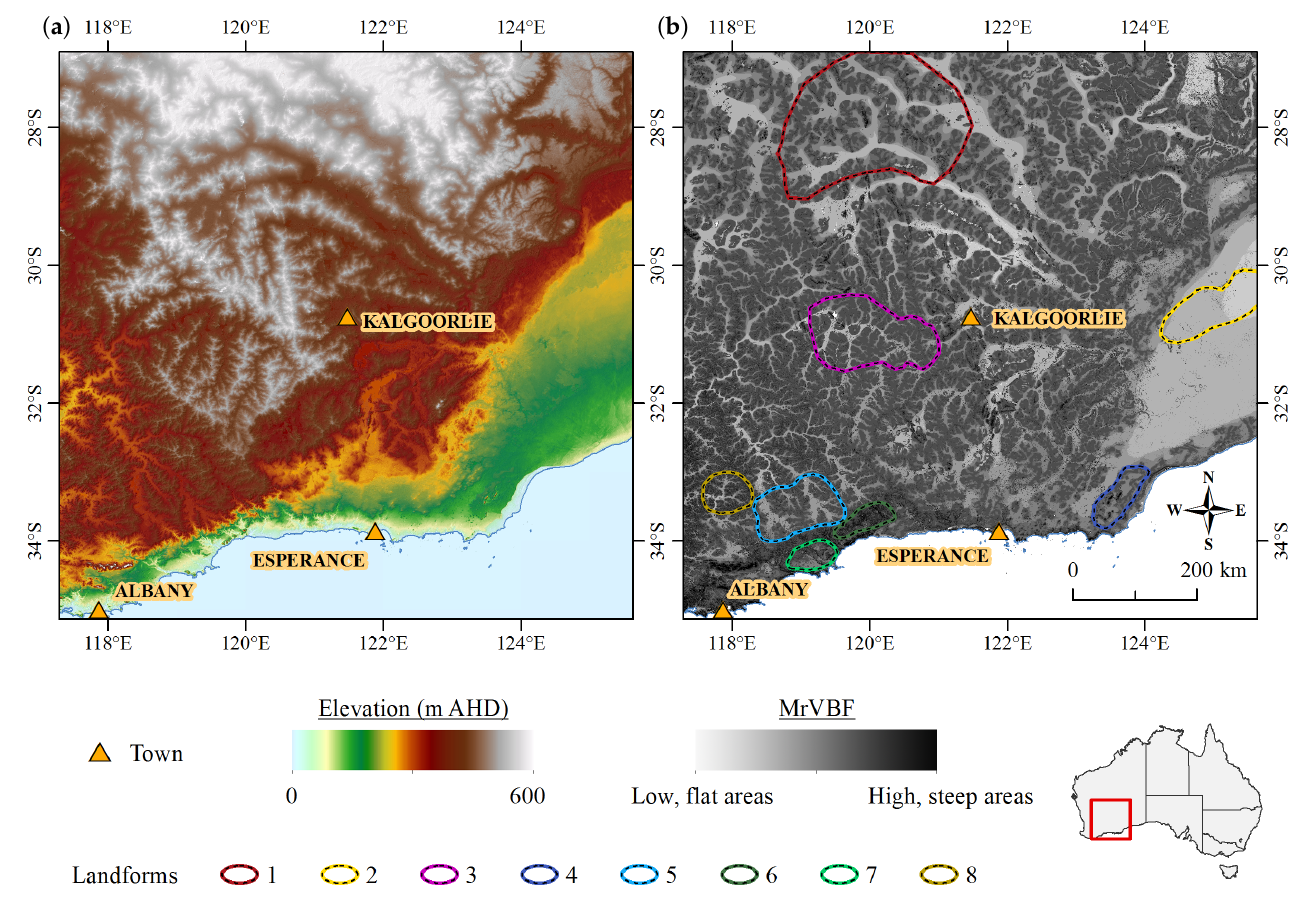
Figure 1. ( a ) DEM [41] of the study area. ( b ) Multiresolution valley bottom flatness map (MrVBF, [42]), a subproduct of the DEM, that displays low slope gradients in lighter shade and high slope gradients in darker shade. Colour indicates the eight flatness surface patterns used in this